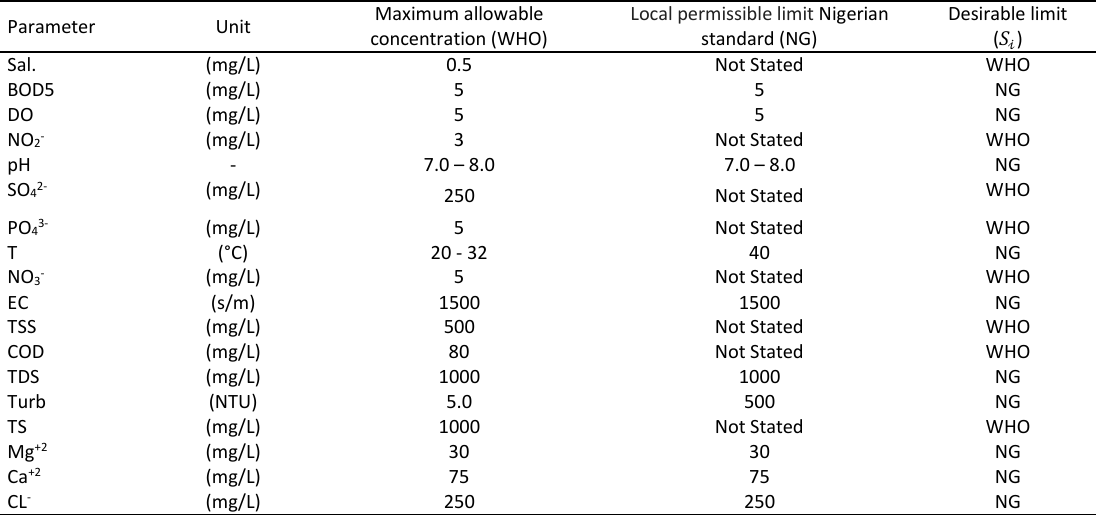
Table 3: Water quality standards used in the current study